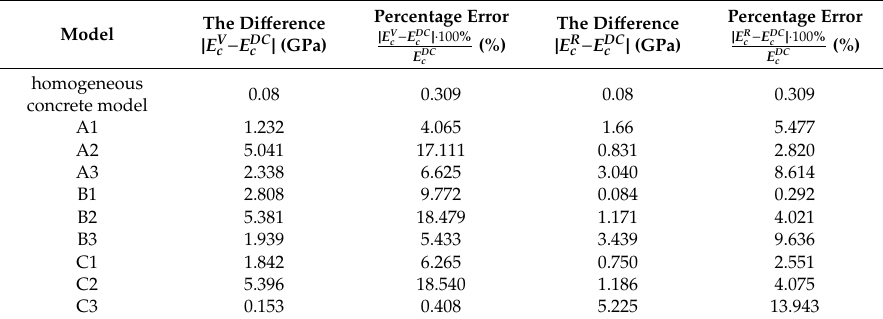
Table 4. Di ff erences between theoretical and numerical results. Table 3. Parameters of numerical models.